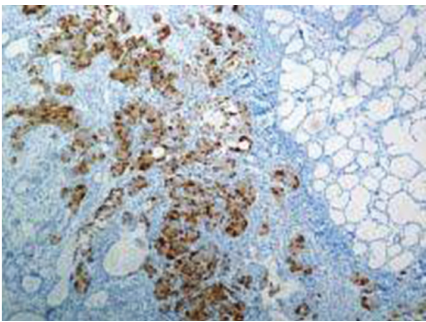
Figure 2: Carcinoid tumor cells showing positive reaction to chromogranin (DAB/Haematoxylin, ×